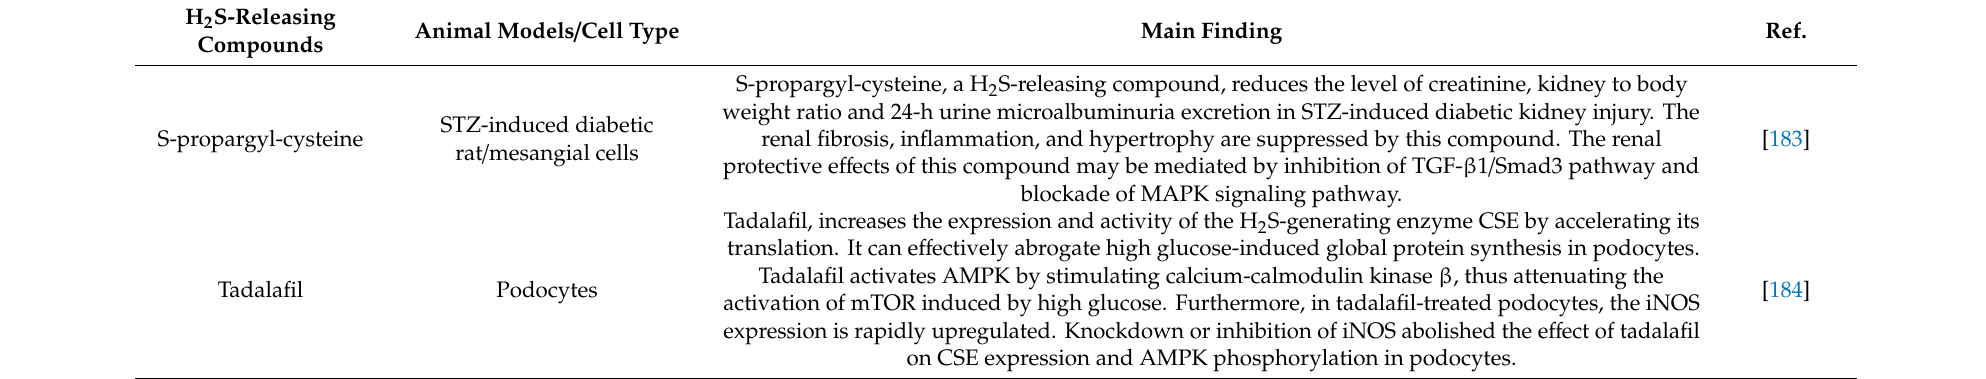
Table 3. Beneficial e ff ect of H 2 S-releasing compounds on experimental diabetic